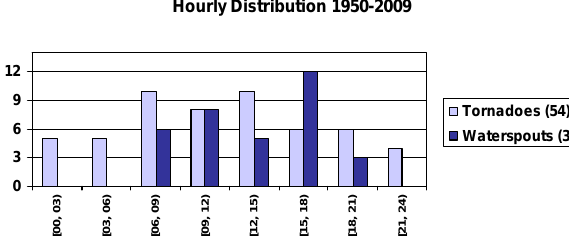
Fig. 4. Temporal evolution of the annual number of tornadoes and waterspouts recorded in the period 1950–2009. Hourly Distribution 1950-2009